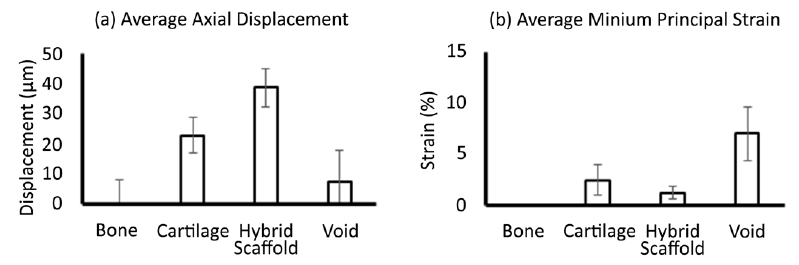
Figure 5. Data collected from subvolumes (n = 3) at slices (n = 5) throughout the 3D volume for total displacement ( a ) and minimum principal strain ( b ). Total displacement was normalised against bone. Average minimum principal strain in bone was less than 0.1%. Values are mean and error bars represent S.D. Data presented here represents Load2: the higher level of compression applied.